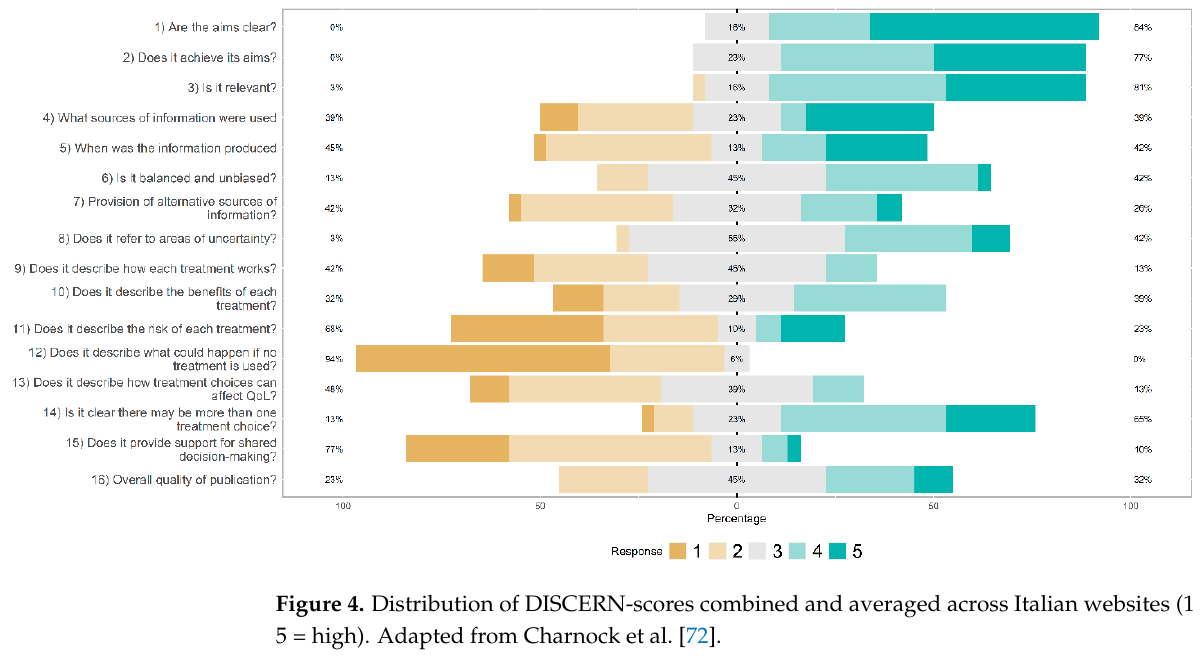
Figure 3. Distribution of DISCERN-scores combined and averaged across English websites (1 = low, 5 = high). Adapted from Charnock et al. [72].